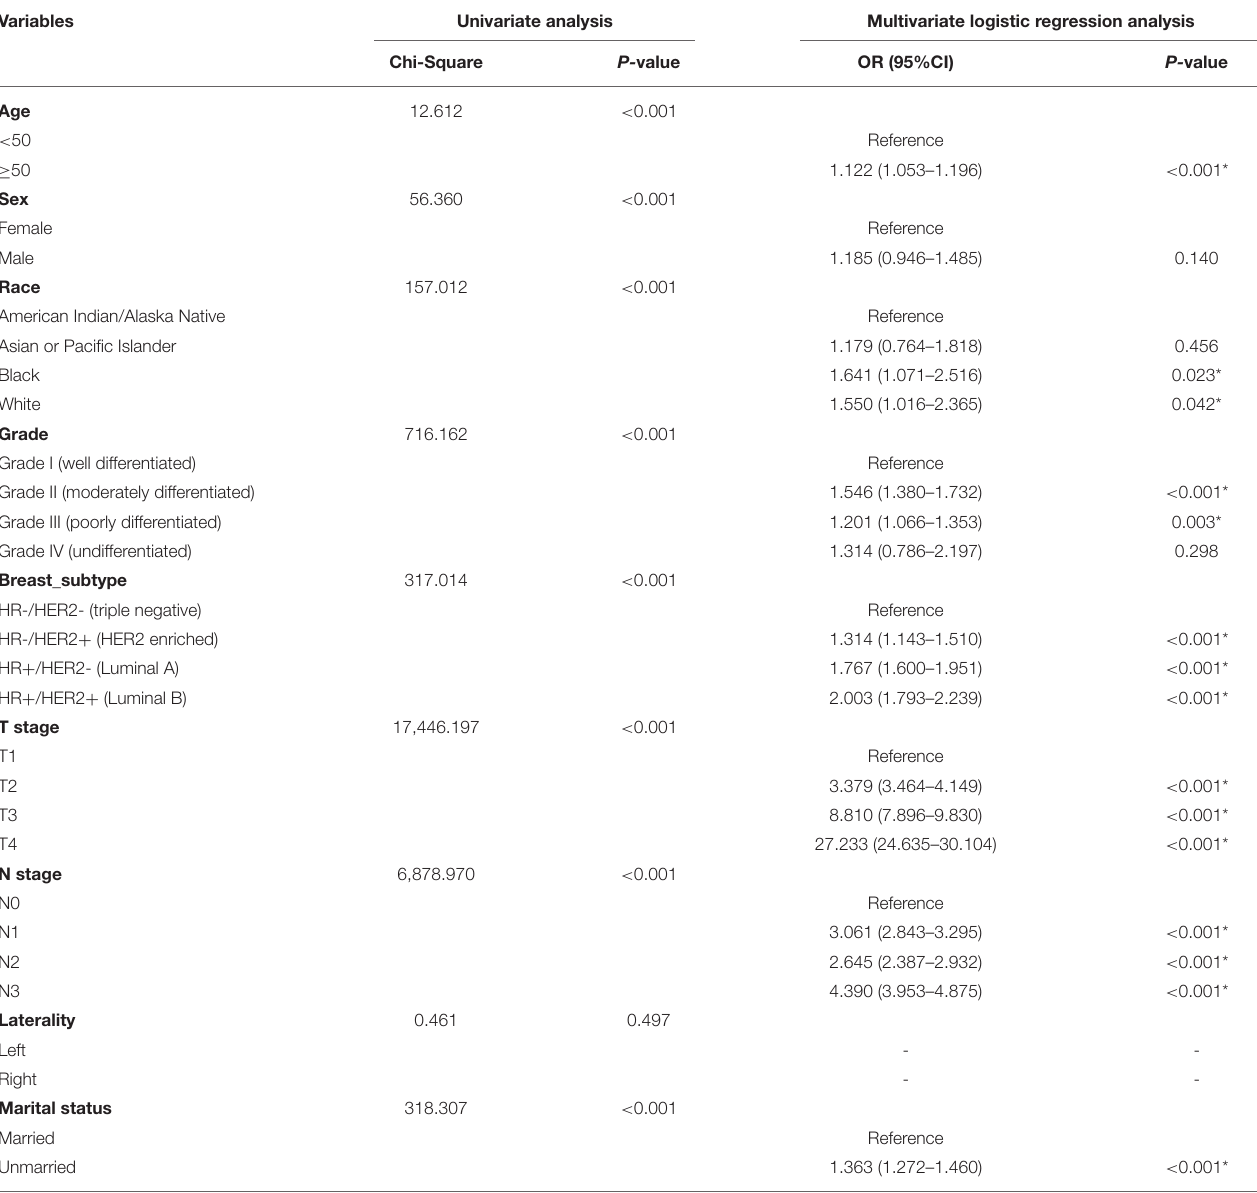
TABLE 3 | Univariate analysis and multivariate logistic regression analysis of